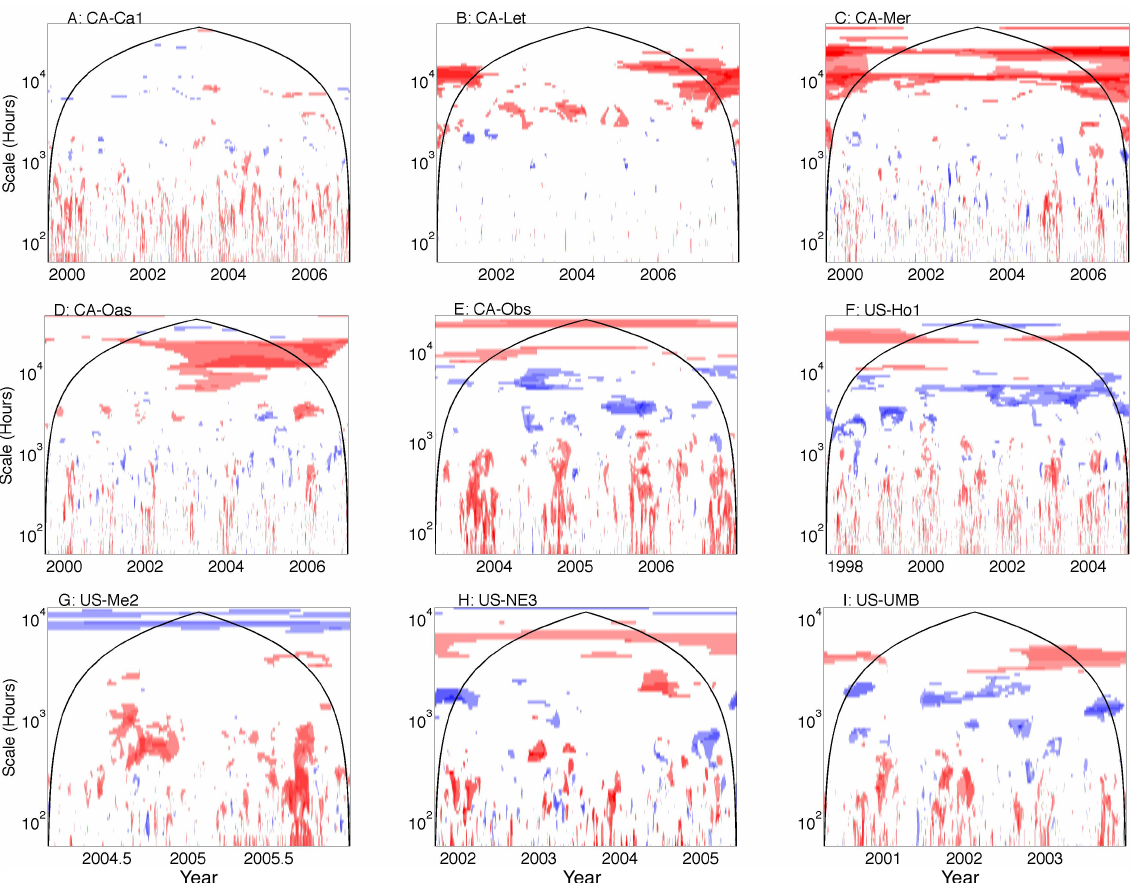
Fig. 7. The ratio of wavelet coherence significance tests for models with different calculations of the net ecosystem exchange (NEE). The color bar follows Fig. 5. Areas of dark blue represent times and scales for which models that calculate NEE as gross primary productivity (GPP) minus ecosystem respiration (ER) are significantly related to NEE measurements and models that calculate NEE as net primary productivity (NPP) minus heterotrophic respiration (HR) are not significantly related to NEE measurements. Regions for which models that calculate NEE as NPP minus HR are significant and GPP minus ER are not significant are dark red. The color bar follows Fig.